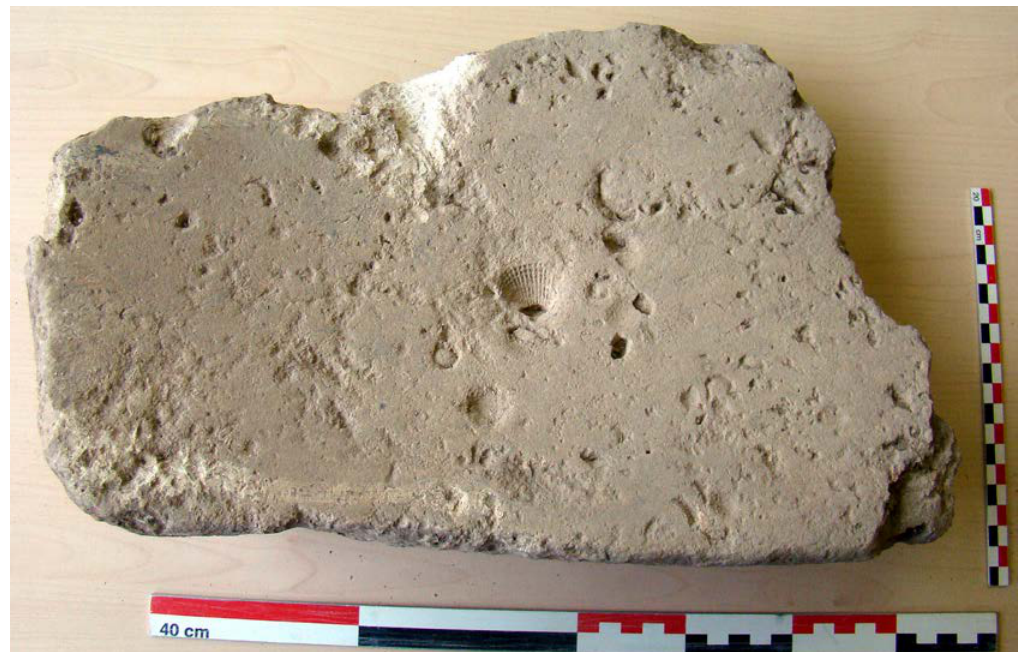
Figure 4. Example of a very slightly sandy vacuolar limestone saddle quern with a grinding surface tending to become massive. Early Iron Age (Hallstatt), Reims area, France.